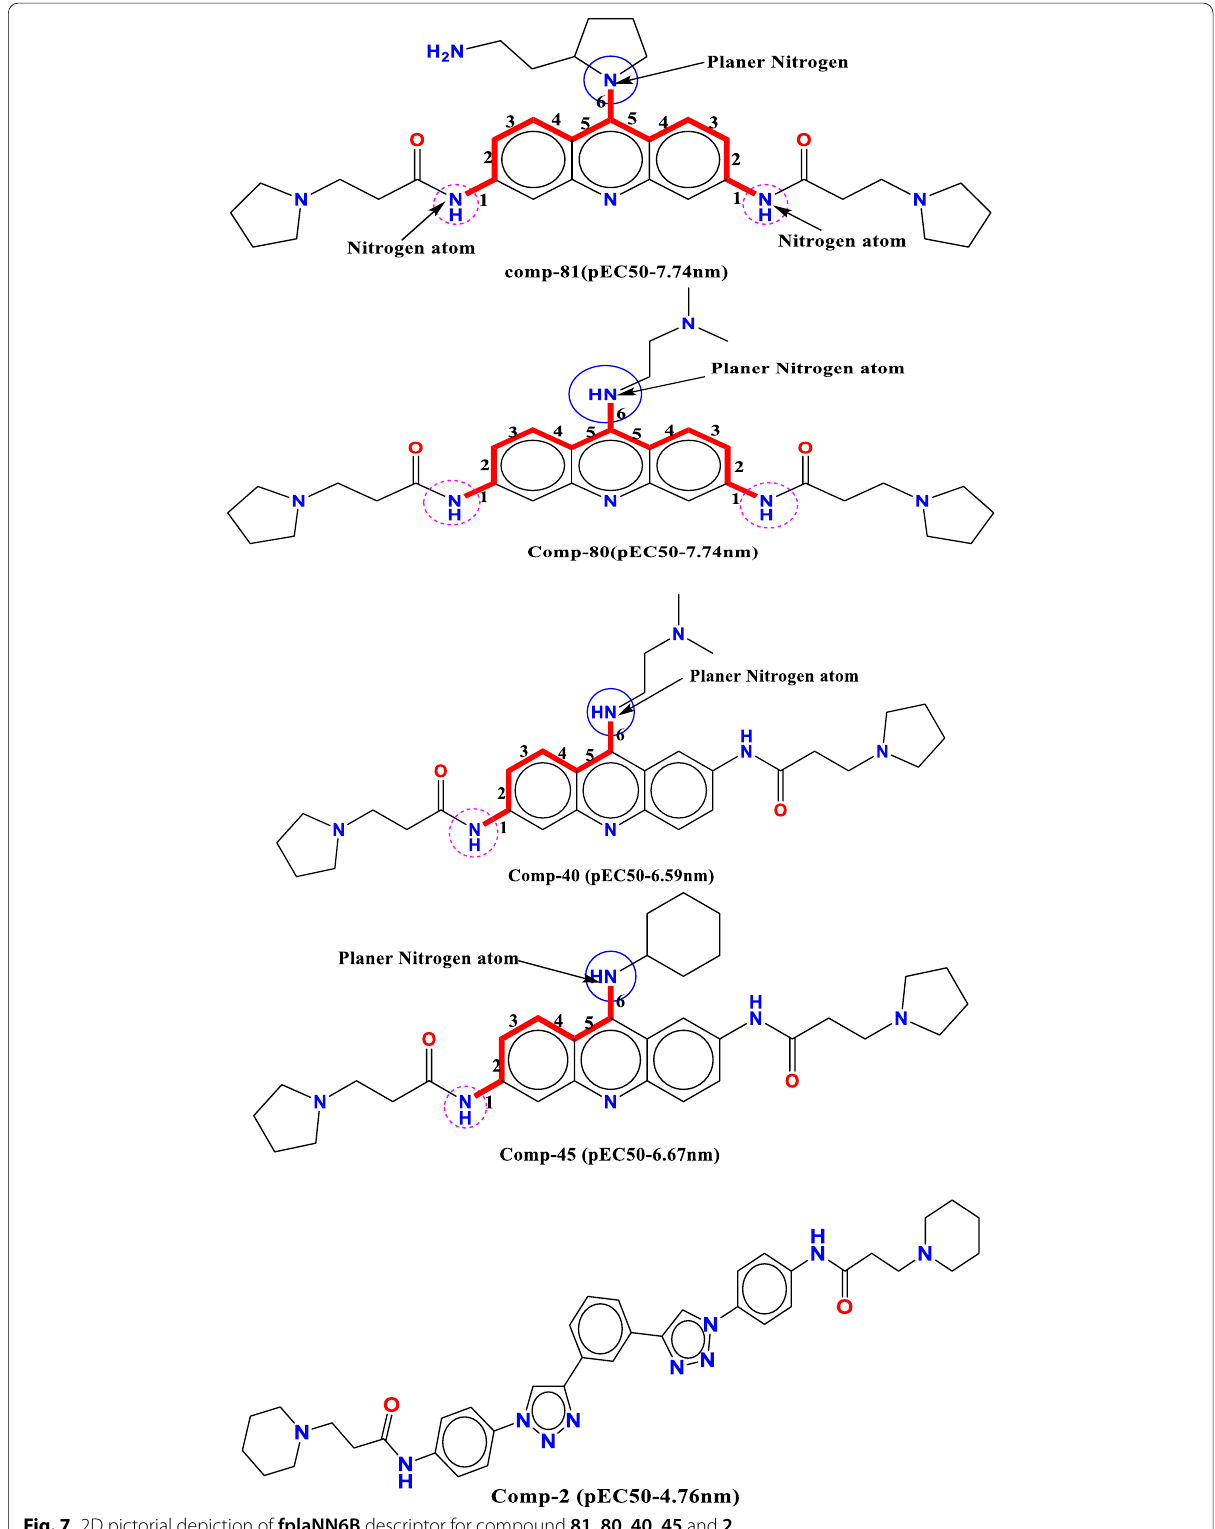
Fig. 7 2D pictorial depiction of fplaNN6B descriptor for compound 81, 80, 40, 45 and